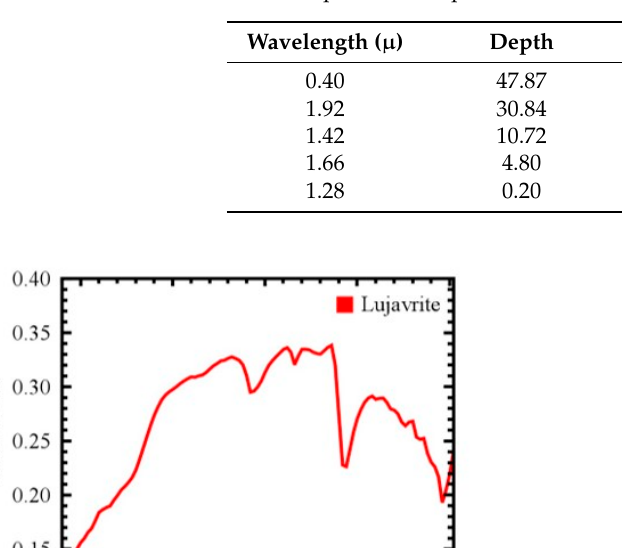
Figure 9. ( A ) Absorption characteristics of the continuum removal spectra of Lujavrite; ( B ) Charac- terization of the in situ spectra of Lujavrite. Table 3. Spectral absorption characteristics of lujavrite. Table 3. Spectral absorption characteristics of lujavrite.